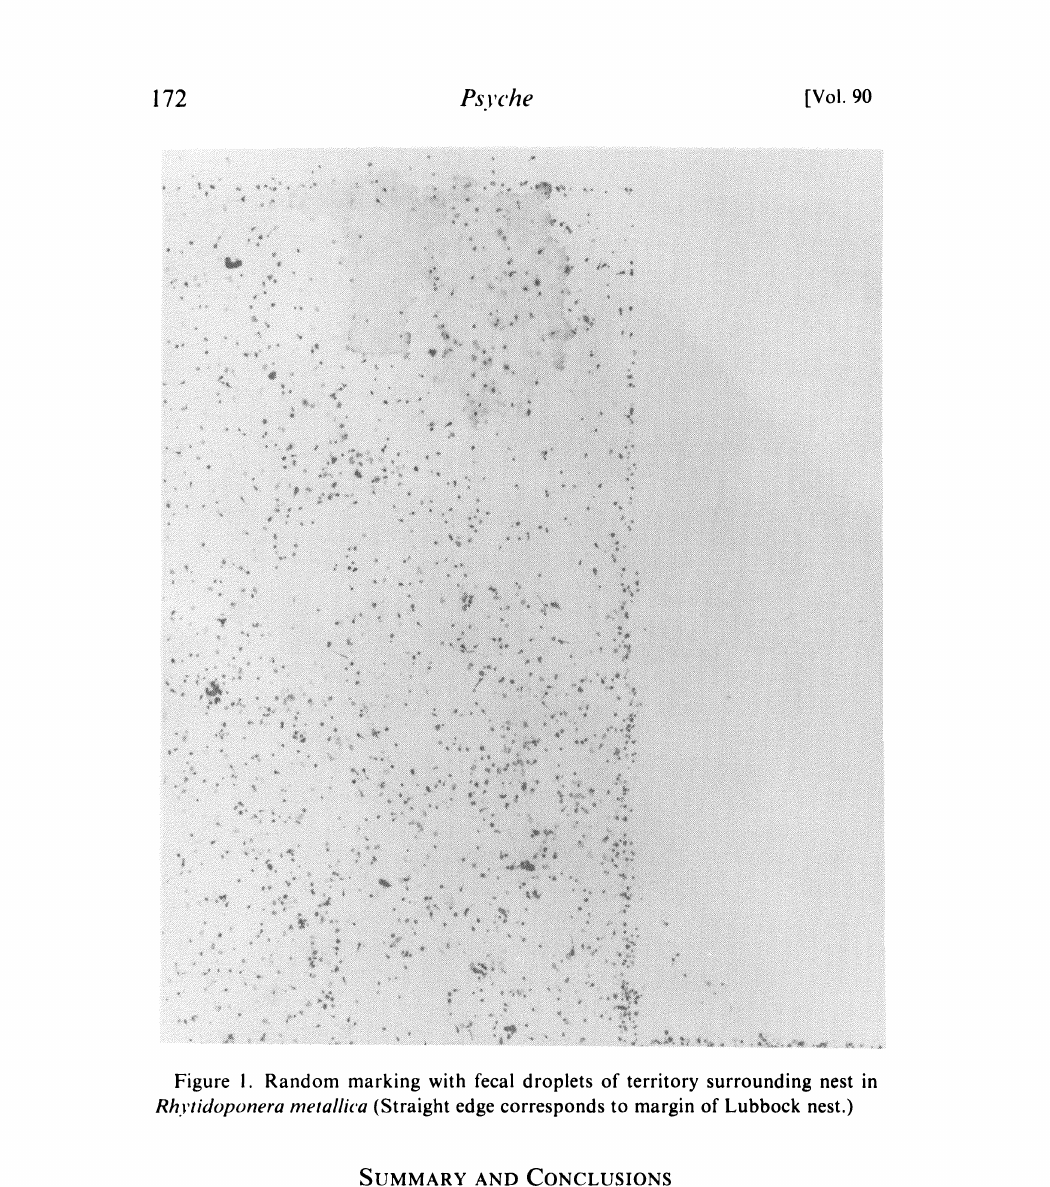
Figure 1. Random marking with fecal droplets of territory surrounding nest in Rhytidoponera metallica (Straight edge corresponds to margin of Lubbock